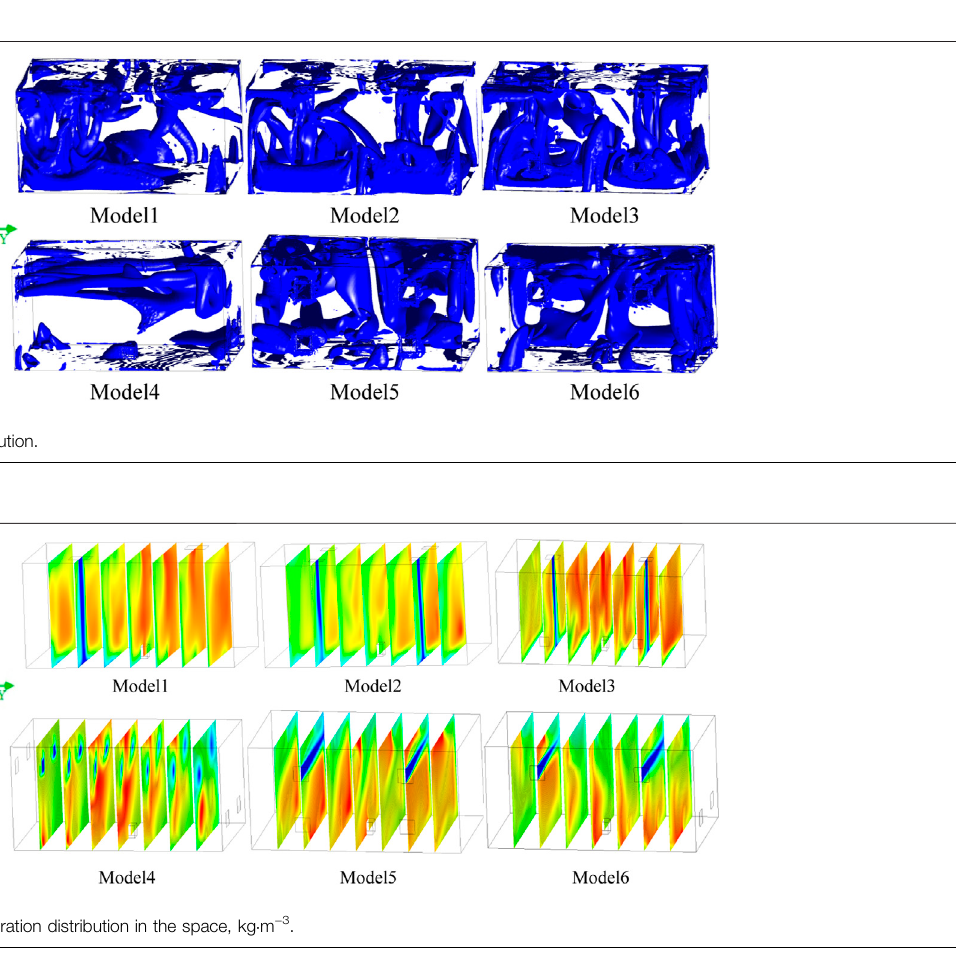
Frontiers in Energy Research |